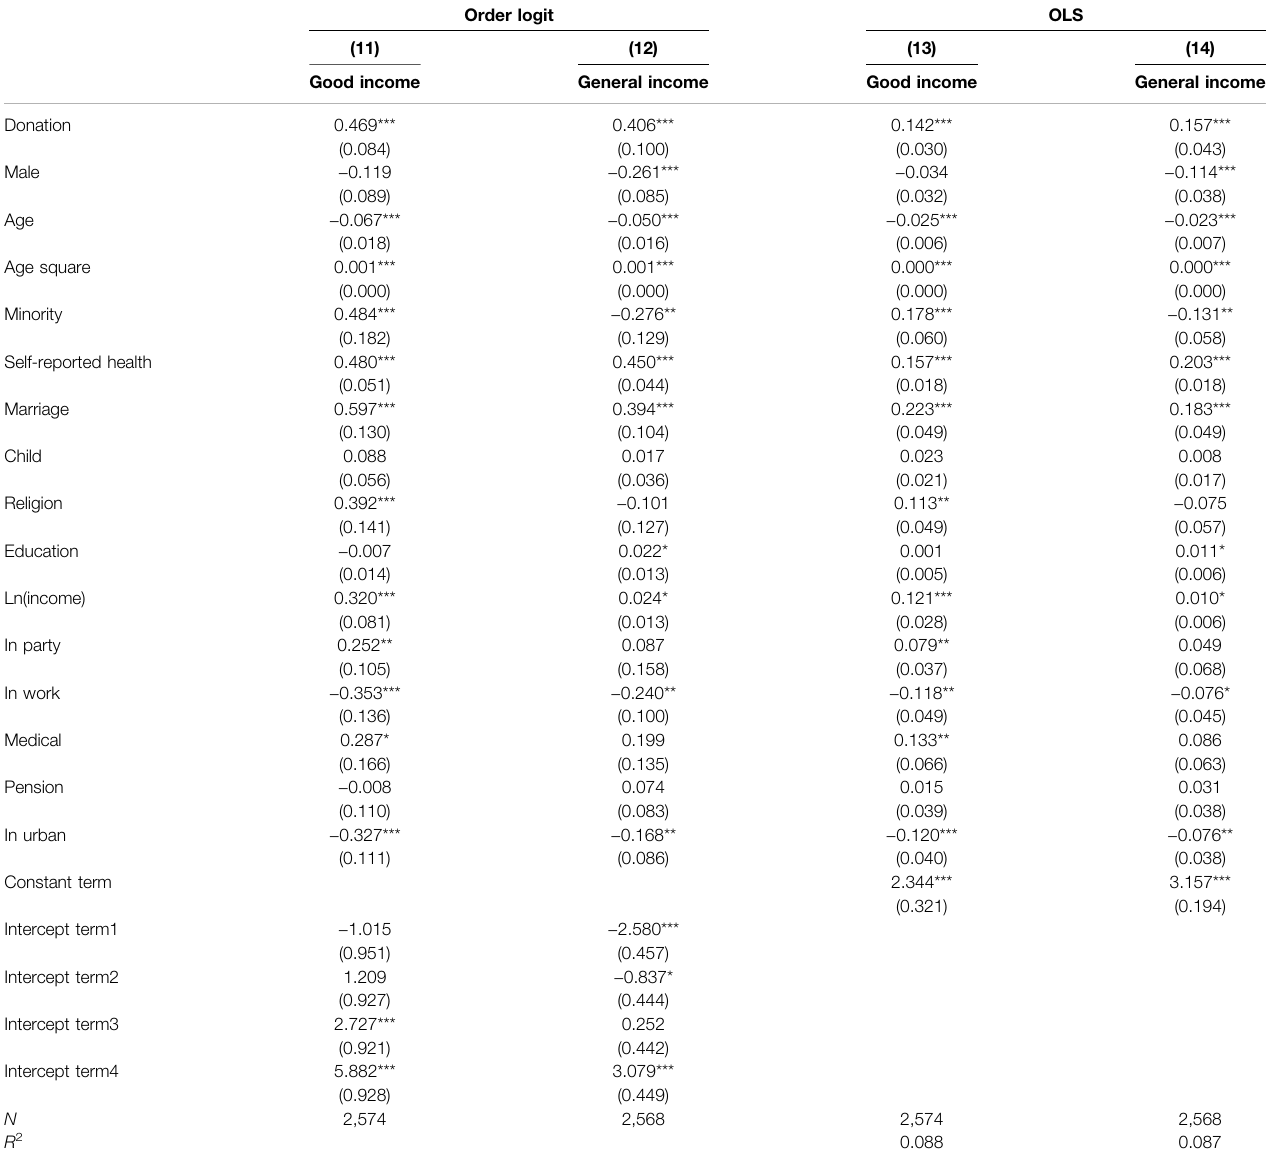
TABLE 7 | Discussion of different income